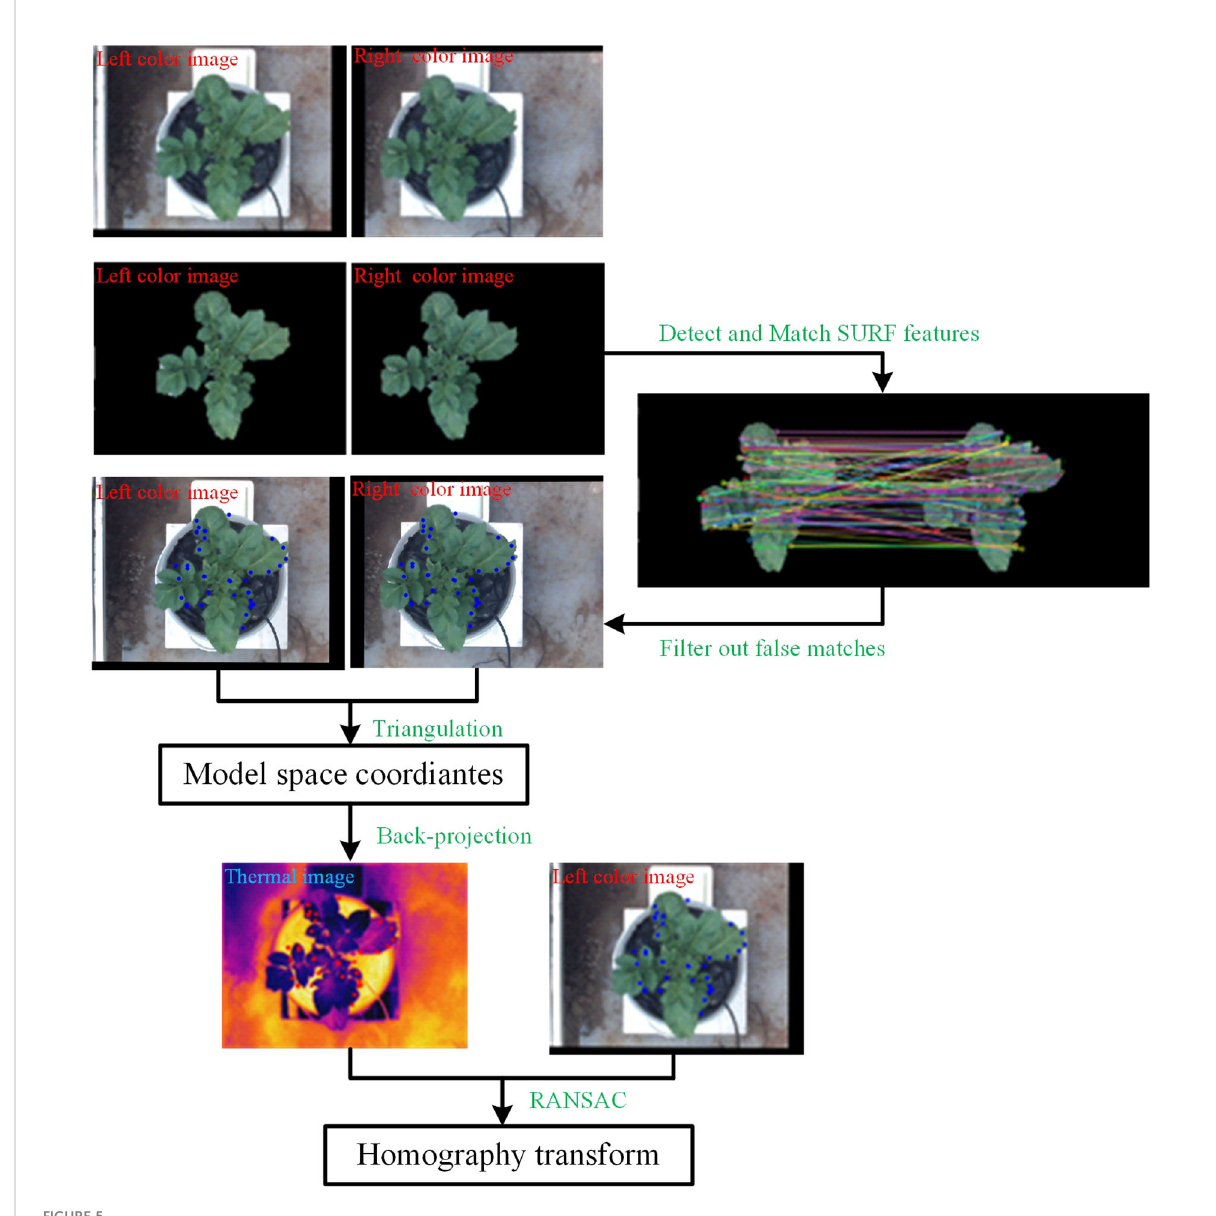
FIGURE 5 Example of coarse registration of color and thermal